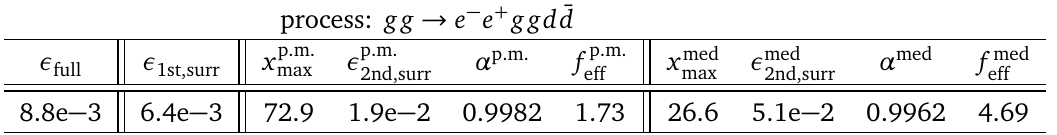
Table 2: Sampling measures for the g g → e − e + g gd ¯ d partonic channel in pp colli- (cid:112) s = 13TeV. All efficiencies, the sample-size parameters and effective gain sions at factors are determined in the generation of 100k unweighted